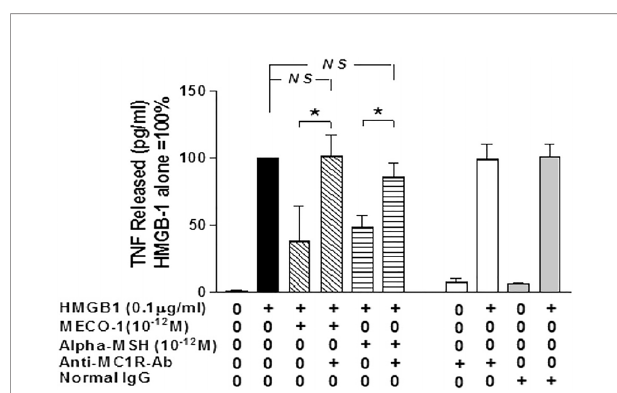
FIGURE 4 | MC1R antibody blocks the in fl ammatory suppressant effect of MECO-1 and of a -MSH.[Reproduced from (59)]. Murine macrophages-like RAW 264.7 cells were pretreated with anti-MC1R Ab for 10 min prior to addition of HMGB1 with/without MECO-1 or a -MSH at 10-12 M. The TNF content of the cell- free medium was determined by ELISA after 6hr. Figure from npj bio fi lms (59) permissible to reuse under a CC-BY 4.0 license. (*) refers to statistically signi fi cant p value i.e P < 0.05. NS means not statistically signi fi cant p value i.e. P >